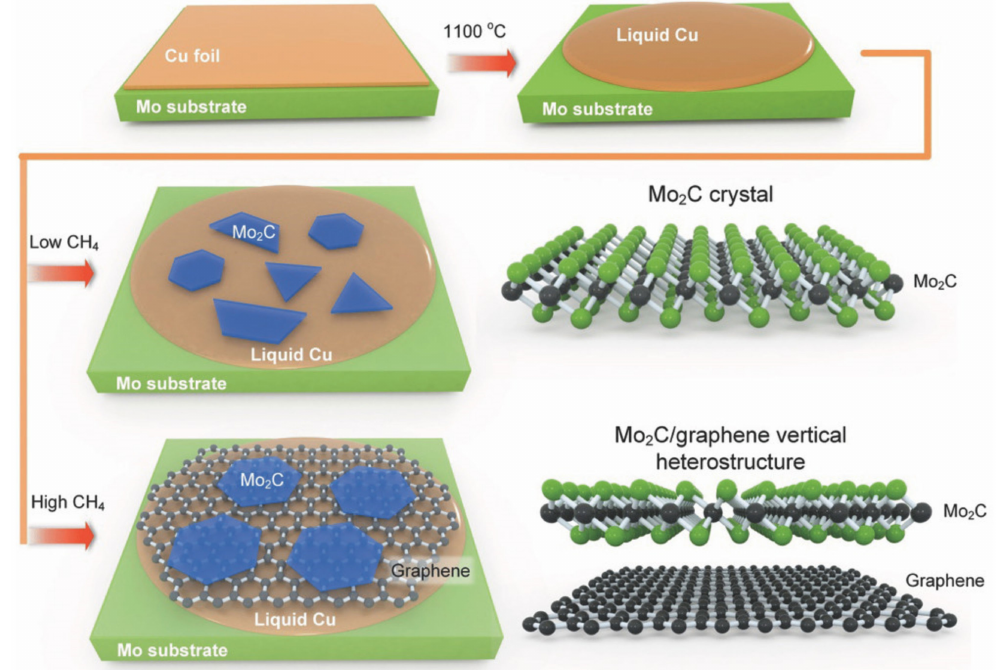
Figure 6. Schematic display of the growing process of Mo 2 C/graphene heterostructure at low and high CH 4 flow rates. At low CH 4 concentration, Mo 2 C crystals with different shapes and thicknesses are randomly distributed on the copper surface, while at high CH 4 concentration, hexagonal thin Mo 2 C sheets are mainly grown on graphene. Reprinted with permission from Ref. [86]. 2017, John Wiley and